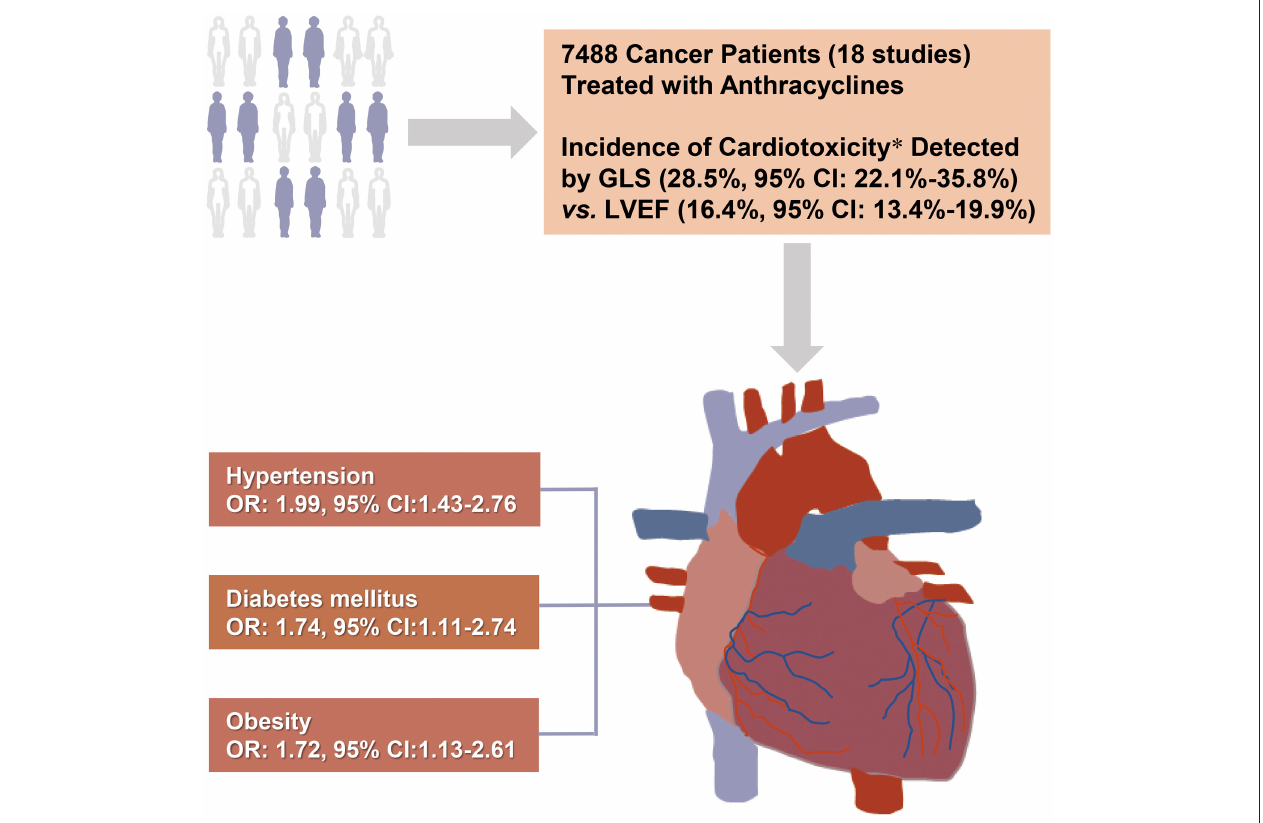
FIGURE 7 | Central illustration: Risk factors for anthracycline-induced cardiotoxicity. The present systematic review included 18 studies of 7,488 cancer patients receiving anthracycline chemotherapy. Hypertension, diabetes, and obesity were identified as risk factors for anthracycline-induced cardiotoxicity. GLS showed higher detection rate and better early detection ability for cardiotoxicity than LVEF. *6 of the 18 studies used both LVEF and GLS. CI, confidential interval; LVEF, left ventricular ejection fraction; GLS, global longitudinal